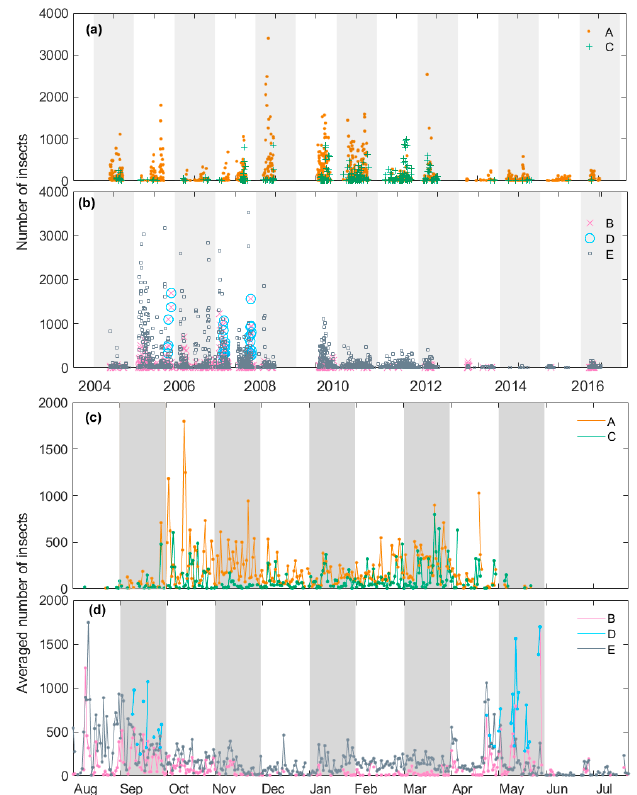
Figure 6. Annual ( a , b ) and monthly ( c , d ) variation in nightly insect numbers in the different target classes. ( a , c ) Classes A and C. ( b , d ) Classes B, D and E. Monthly variation was calculated as the nightly average for each date over 9 years. Each background bar (alternating grey and white) indicates a migratory season ( a , b ) or a month ( c , d ).